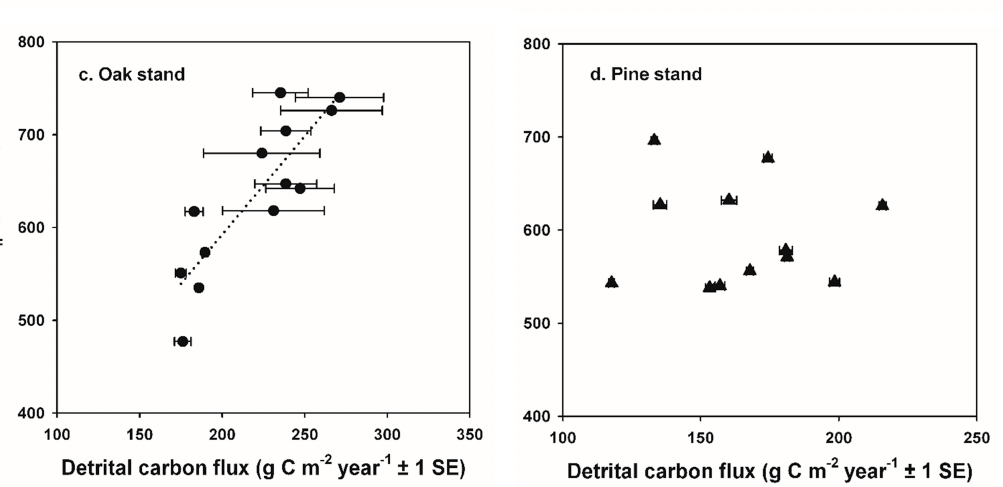
Figure 4. Relationships between eddy covariance and biometric measurements at the oak and pine stands. Maximum growing season leaf area index (LAI; m 2 m − 2 ) and gross ecosystem production (GEP; g C year − 1 ) at the ( a ) oak and ( b ) pine stands, and the relationship between the sum of modeled carbon flux during the decomposition of fine litter in the L horizon of the forest floor, CO 2 release from snags and coarse woody debris on the forest floor (sum of detrital C flux; g C year − 1 ), and estimated heterotrophic respiration (R h ; g C year − 1 ) at the ( c ) oak and ( d ) pine stands are shown. Statistics are in Table 2.